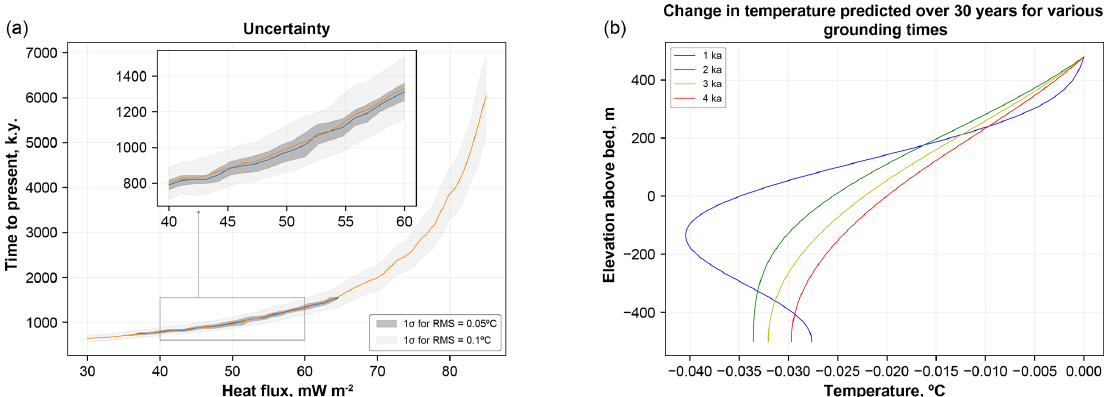
Figure 7. Uncertainties associated with ice rise age inversion from temperature–depth profiles. (a) Combinations of values of heat flux and timing of grounding used in the synthetic inversion experiment that yield 0.1 ◦ rms (mean indicated by orange line with light grey band around it indicating standard deviation) and 0.05 ◦ C rms (mean indicated by blue line with dark grey band around it indicating standard devi- ation) misfit with “measured” temperature profiles, respectively. (b) Temperature profile difference curves showing potential detectability of grounding-induced changes in the lower part of the ice column by repetitive englacial thermometry (for a time interval between measurements of 30 years for four different timings of